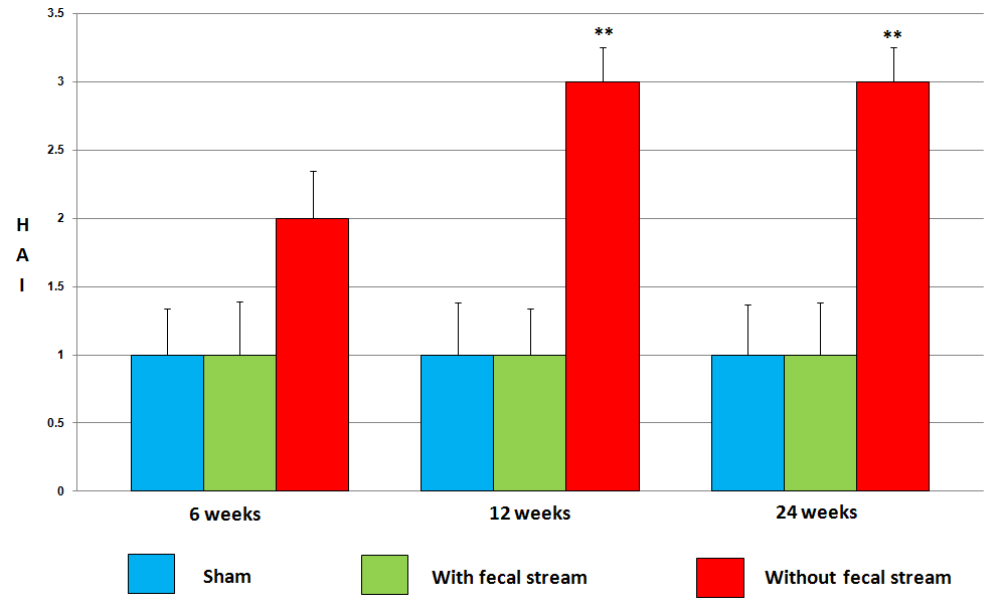
FIGURE 2 – HAI in sham and experimental subgroups (colon segments with and without fecal stream) for different durations of fecal stream diversion. ** = significant difference (without fecal stream × control and with fecal stream). Mann-Whitney